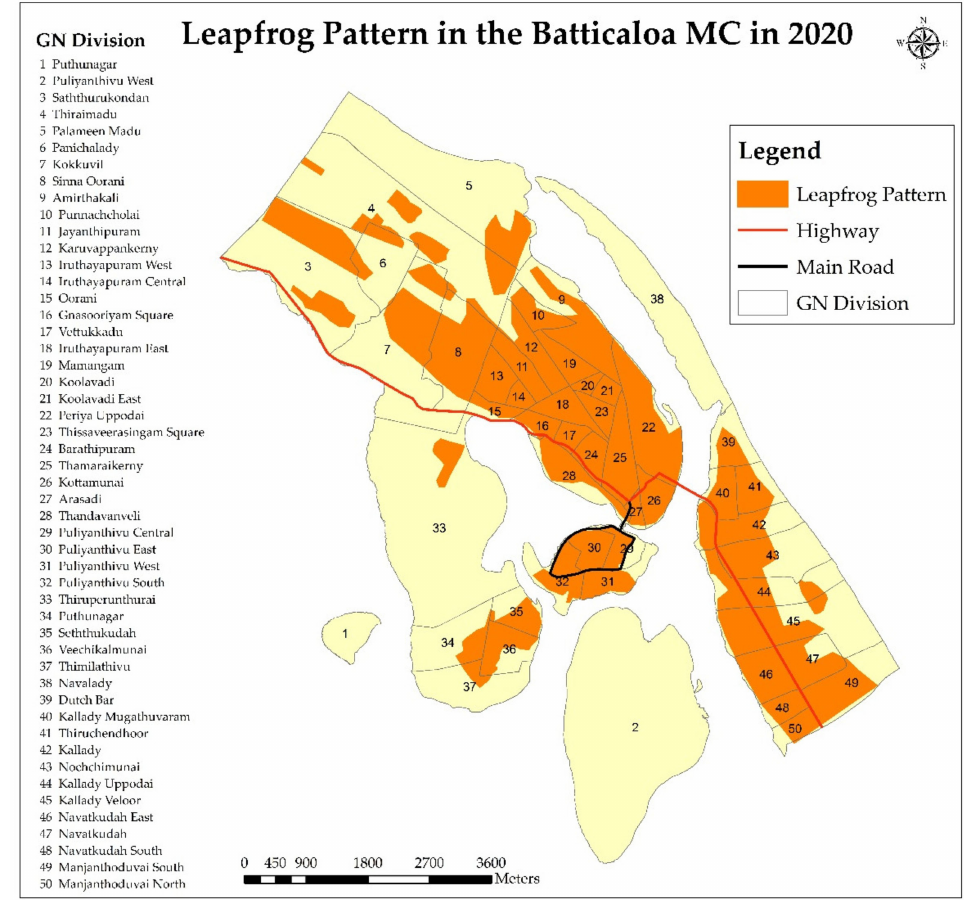
Figure 8. A leapfrog development pattern in the Batticaloa